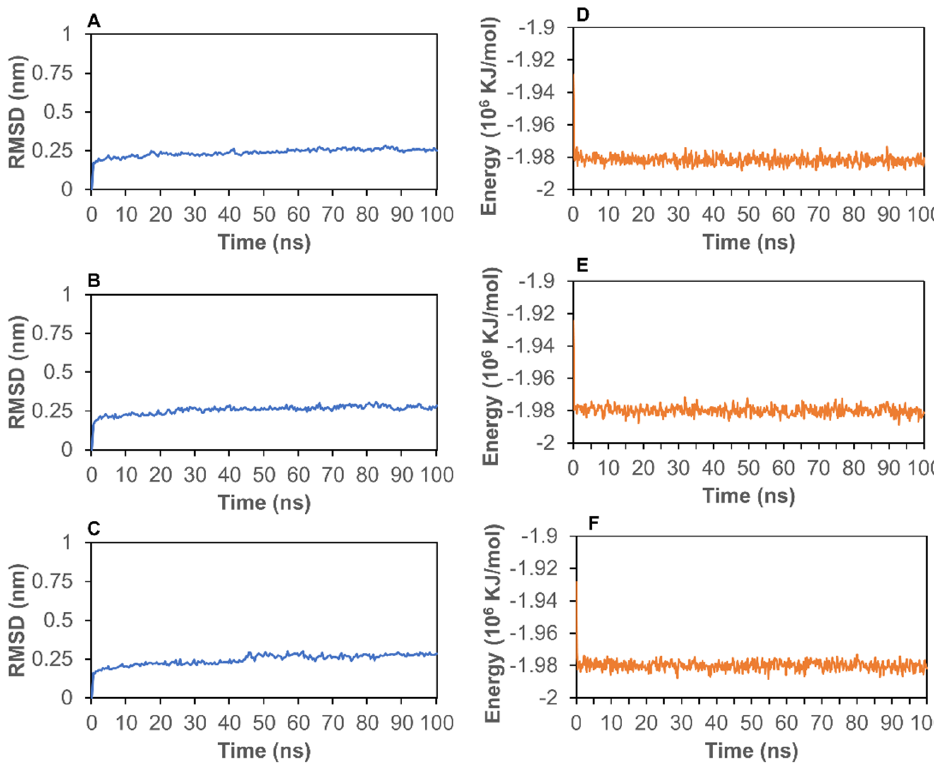
Figure 2. The RMSD and energy of protein–ligand complexes. ( A ), the RMSD of 7BV2–cyanidin 3- O -rutinoside; ( B ), the RMSD of 7BV2–petunidin 3,5- O -diglucoside; ( C ), the RMSD of 7BV2–del- phinidin 3- O -rutinoside; ( D ), the energy of 7BV2–cyanidin 3- O -rutinoside; ( E ), the energy